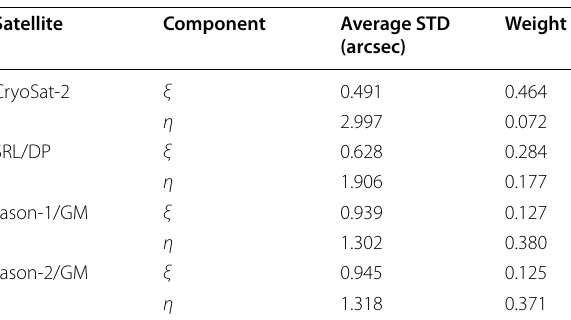
Table 9 Weight distribution without HY-2A